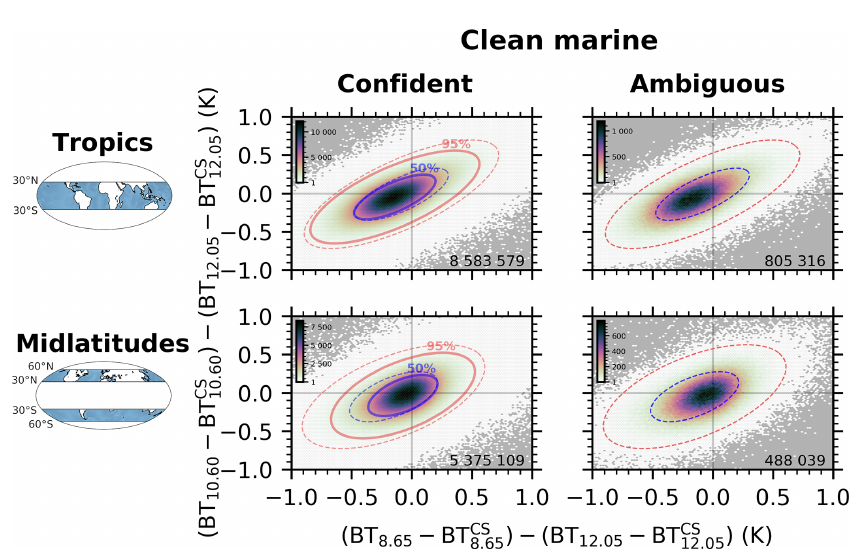
Figure 7. As Fig. 5 for clean marine monolayer observations with τ < 0 . 2 and z top < 4km (99% of all clean marine observations). The solid red and blue ellipses represent the 95% and 50% confidence intervals of the 2-D Gaussian PDF estimated from the confident observations of this specific z top – τ grid and used in the IIR CAD score definition (Eq.